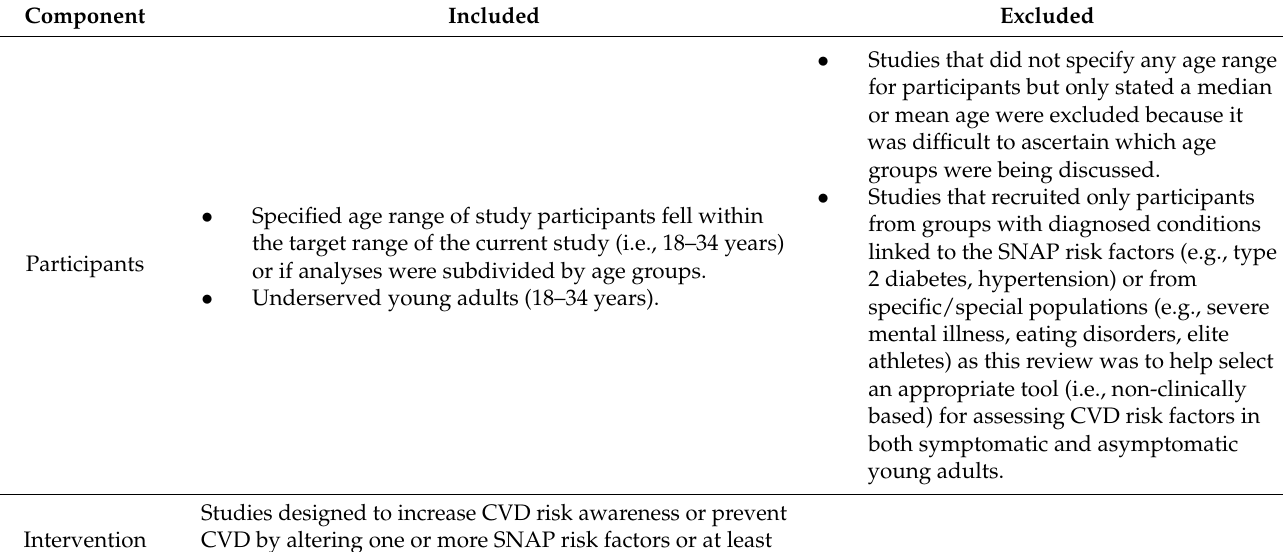
Table 2. Inclusion and exclusion criteria of the